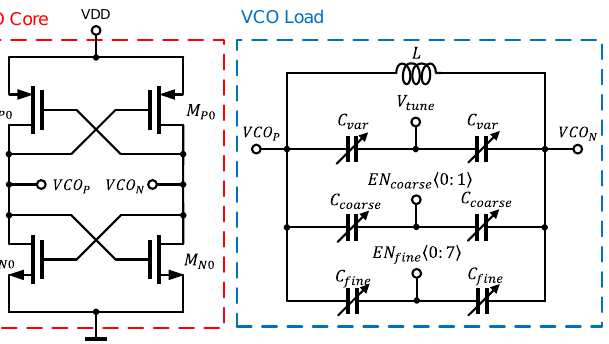
Figure 3. Schematic of the proposed voltage-controlled oscillator (VCO) with a varactor-only capacitor array.